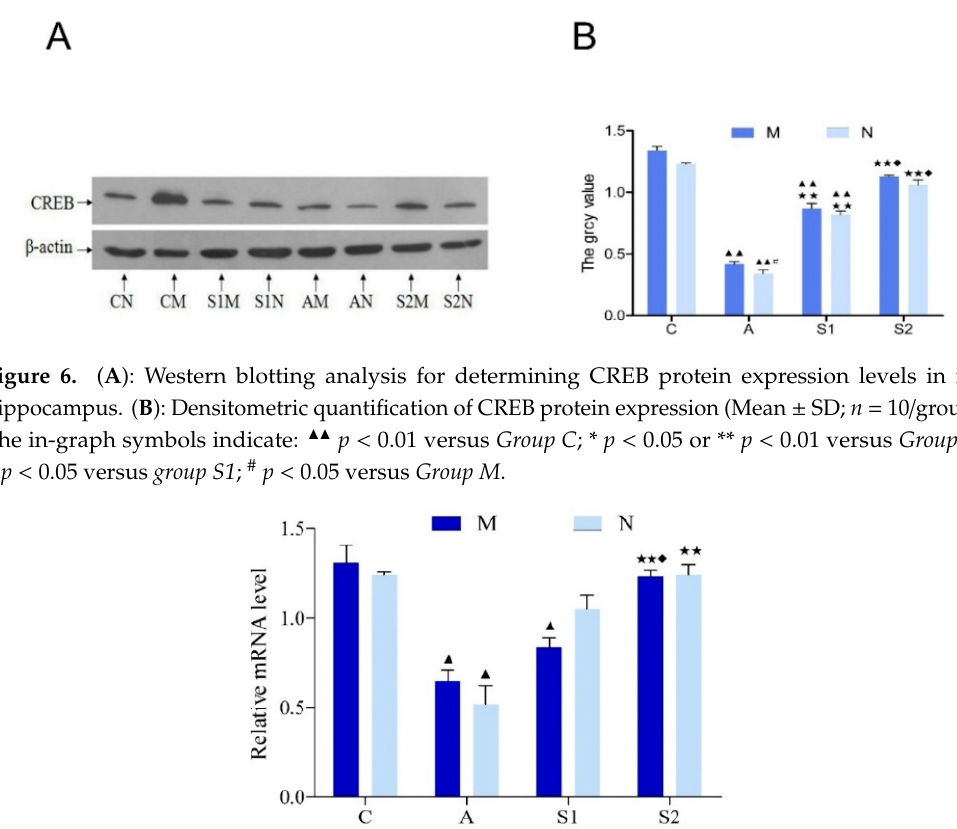
Figure 7. Changes of CREB mRNA expression in rat hippocampus. After the real-time PCR reactions were completed, the relative gene expressions were calculated using the 2 − ΔΔ CT method. Data are presented as Mean ± SD ( n = 10/group). The in-graph symbols indicate: ▲ p < 0.05 versus Group C ; ** p < 0.01 versus Group A ; ◆ p < 0.05 versus Group S1 .